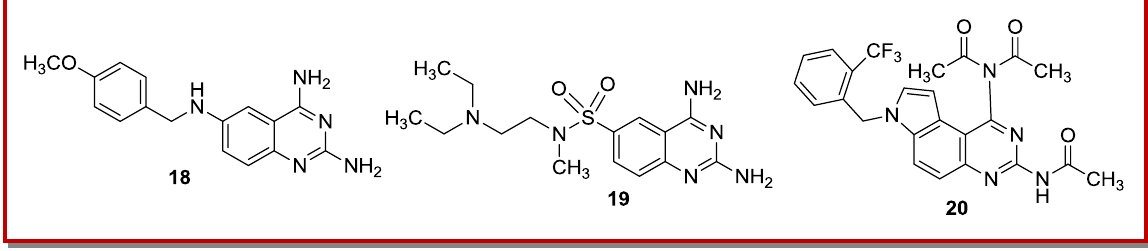
Figure 10: Some quinazoline motifs with antimalarial activity